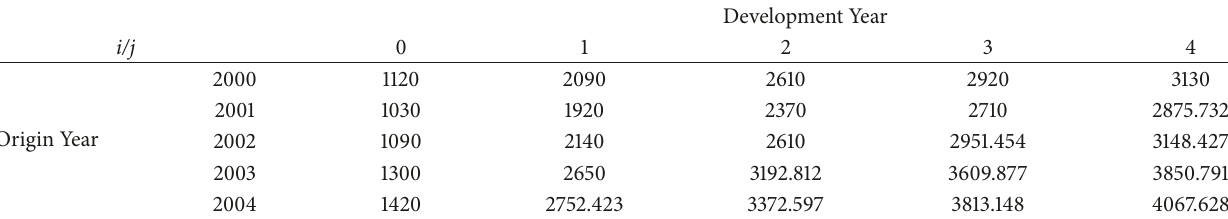
Table 6: Predicted incremental payments of the run-off triangle Table 2.